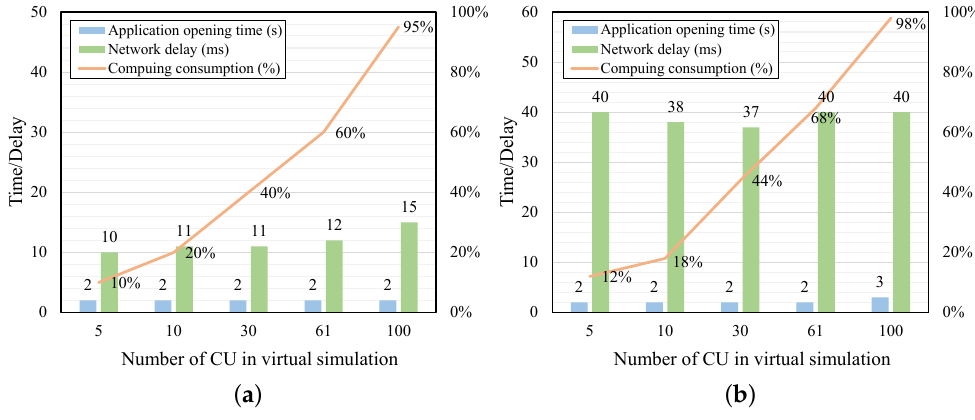
Figure 11. Performance of virtual simulation. ( a ) Our proposal; ( b ) traditional system. Under our proposal architecture, the access delay is about 10 ms, the application runs smoothly, and the user does not feel any delay. As the number of concurrent users increased from 5 to 100, the application open time did not change obviously, eventually rising from 2 s to 3 s. The network latency increased slightly, from 10 ms to 15 ms, and the computing power consumption increased from 10 percent to 95 percent. Application opening, delay test, computing power consumption, etc. are shown on the left side of Figure 11. Under the traditional architecture, the access delay is about 40 ms, and the application runs smoothly without affecting the users at all. As the number of concurrent users increased from 5 to 100, the application open time did not change obviously, eventually rising from 2 s to 3 s. The network latency does not change obviously, fluctuating around 40 ms, and the computing power consumption increases from 10 percent to 98